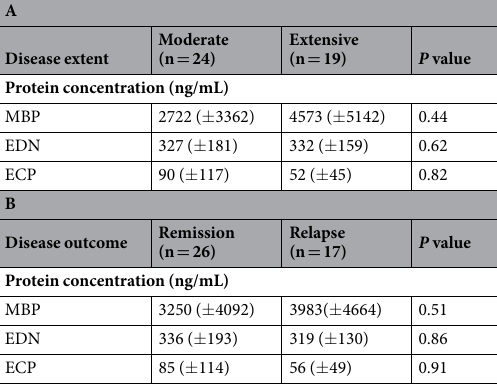
Table 1. MBP, EDN and ECP serum concentrations in patients with BP at the time of diagnosis according to either the extent (A) or the outcome of the disease (B). Extensive disease was defined as more than 10 new